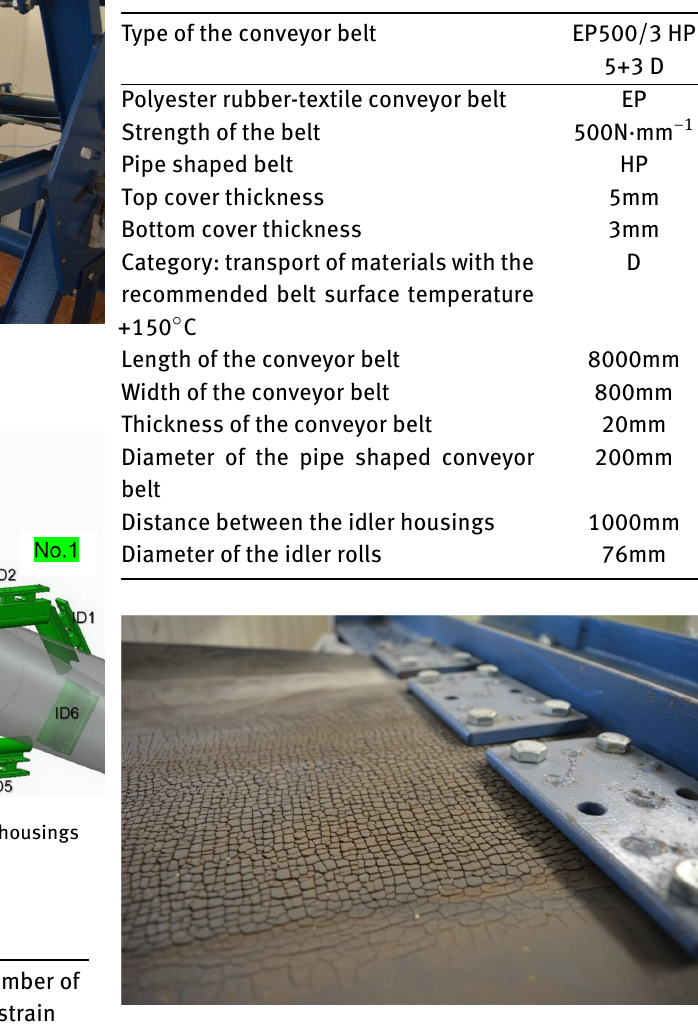
Figure 4: Detail of mounting the end of the conveyor belt